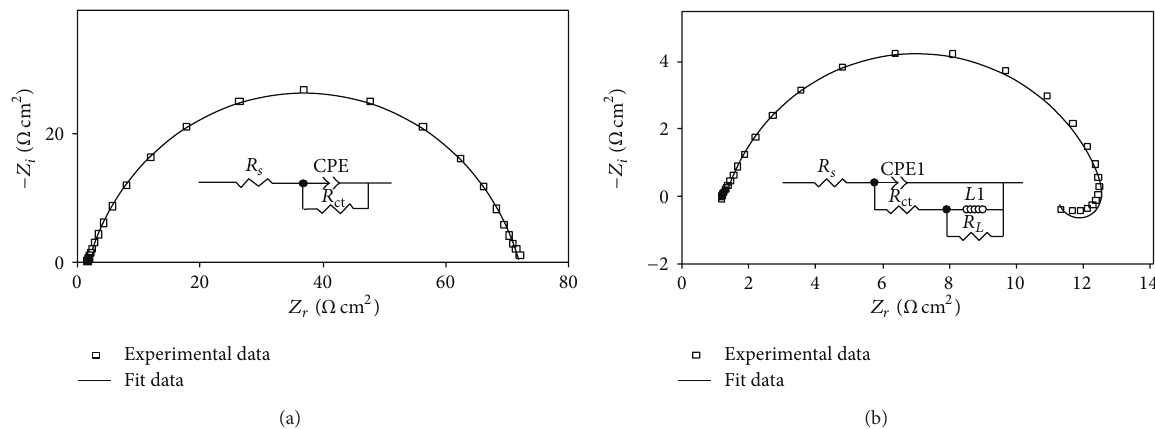
Figure 12: Nyquist plots: ( ◻ ) experimental data and (—) fit data, together with the equivalent circuit used to fit the impedance data, recorded for a C38 electrode (a) in 1M HCl solution + 0.2 mM harmane at 35 ∘ C and (b) in 1M HCl solution + 0.2 mM norharmane at 55 ∘